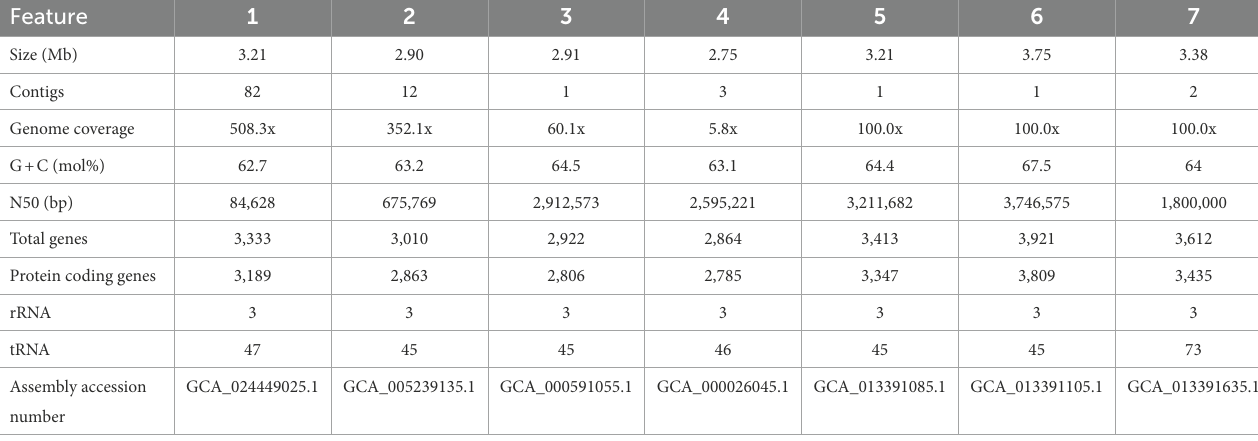
TABLE 1 General features of the genome sequences of Natronomonas aquatica F2-12 T and the type strains of the species of the genus Natronomonas used in this study.